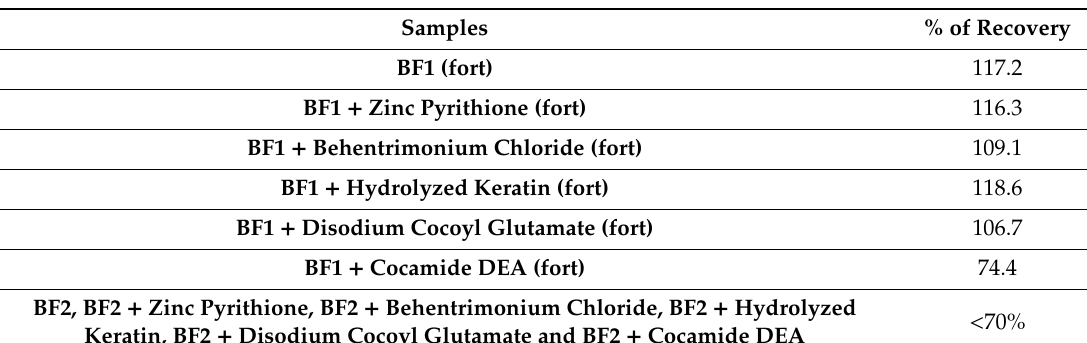
Table 5. Fortification of samples with Kathon TM